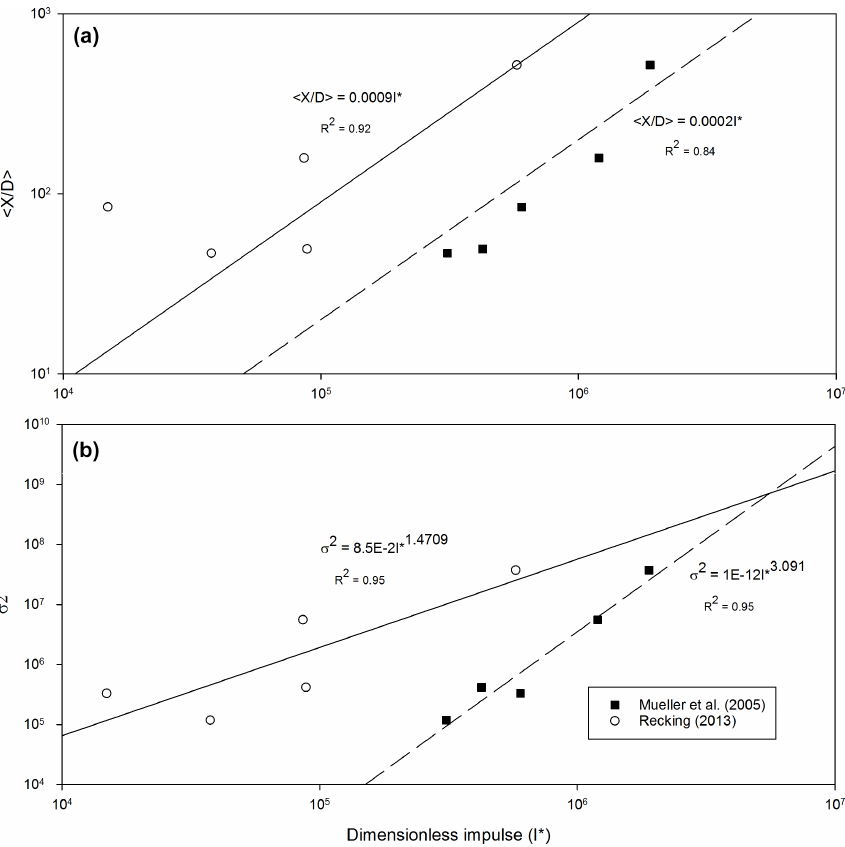
Figure 9. Linear and power-law relations between dimensionless impulse and (a) mean displacement length (< X/D >) and (b) variance ( σ 2 ; Eq. 2) for each tracer